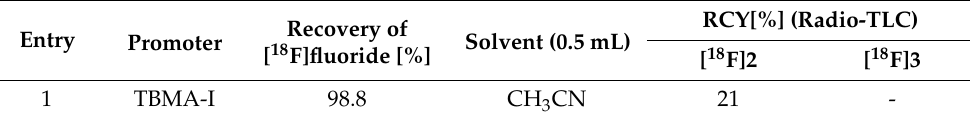
Table 1. Reactivity of TBMA- 18 F for 18 F-substitution of 1,3-ditosylpropane ( 1 ) [13].